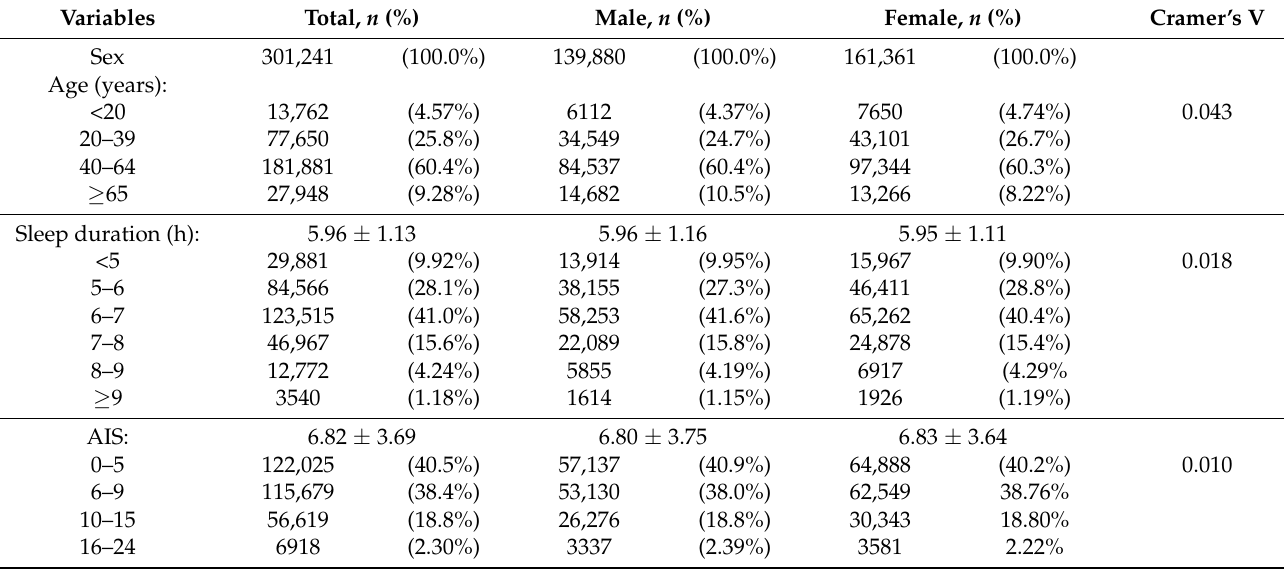
Table 1. Demographic data of participants.